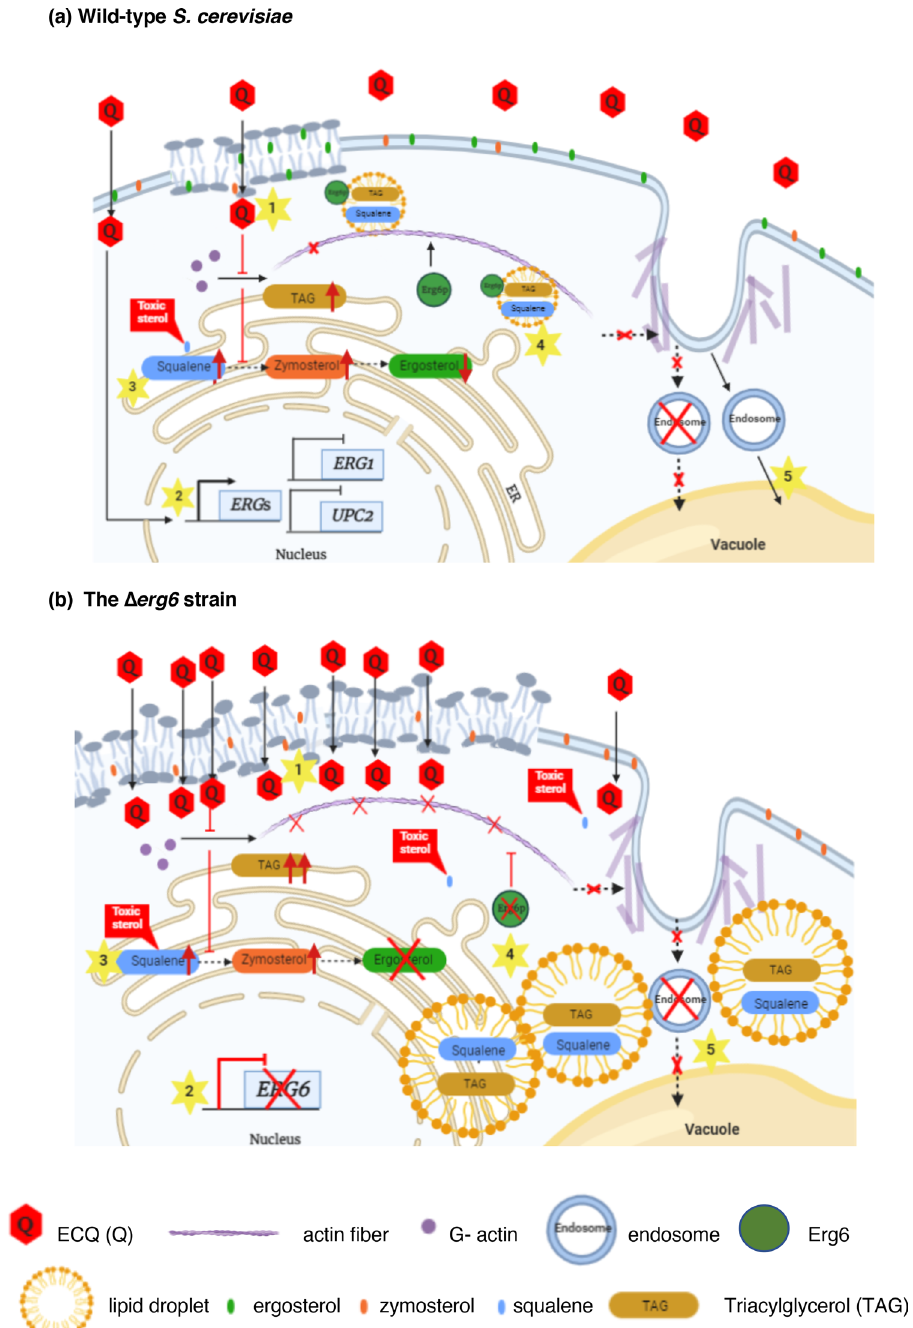
Figure 5. Mode of action of antifungal ECQ in the model yeast S. cerevisiae. ( a ) In wild-type strain, once entered the cells (1), ECQ not only disrupted actin cytoskeleton organization but also strongly induced expression of ERG genes, including ERG6, to compensate for lower ergosterol level (2). ECQ treatment resulted in the alteration of lipid composition (3), leading to increased accumulation of TAG as well as zymosterol and toxic sterol squalene that normally being stored in LDs. LDs formation was induced (4) while some aggregated actin and damaged protein were also removed via endosomes (5) to reduce effect of ECQ cytotoxicity. ( b ) In contrast to the ∆ erg6 strain, membrane permeability was increased (1), allowing penetration of drugs including ECQ. Loss of Erg6 caused pronounced effects on ECQ-mediated inhibition of actin cytoskeleton organization and function (2) and alteration of ergosterol metabolism (3), resulting in elevated levels zymosterol, the defective plasma membrane and abnormal cell morphology. Additionally, despite formation of LDs, they were clustered and non-functional (4), resulting in increased accumulation of toxic squalene. However, newly formed LDs could not be properly destined for vacuolar degradation as a result of ECQ inhibition on actin transport of LDs (5). Overall, ECQ displayed a coupling antifungal mechanism, resulting in abnormal actin cytoskeleton organization and altered sterol and lipid homeostasis. Red arrows indicated a decreased or increased of cellular sterol or TAG levels after treatments with ECQ. Yellow star number 1–5 indicated proposed cellular events during ECQ